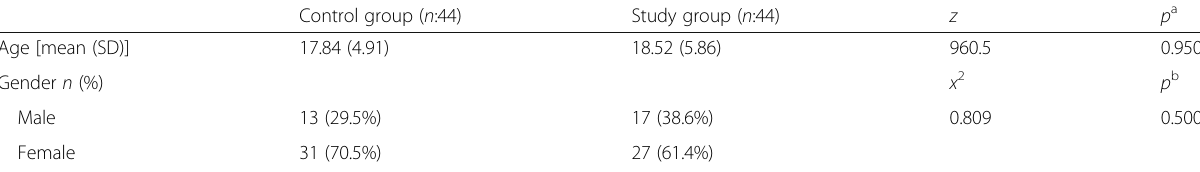
Table 1 Comparison of patients ’ demographic